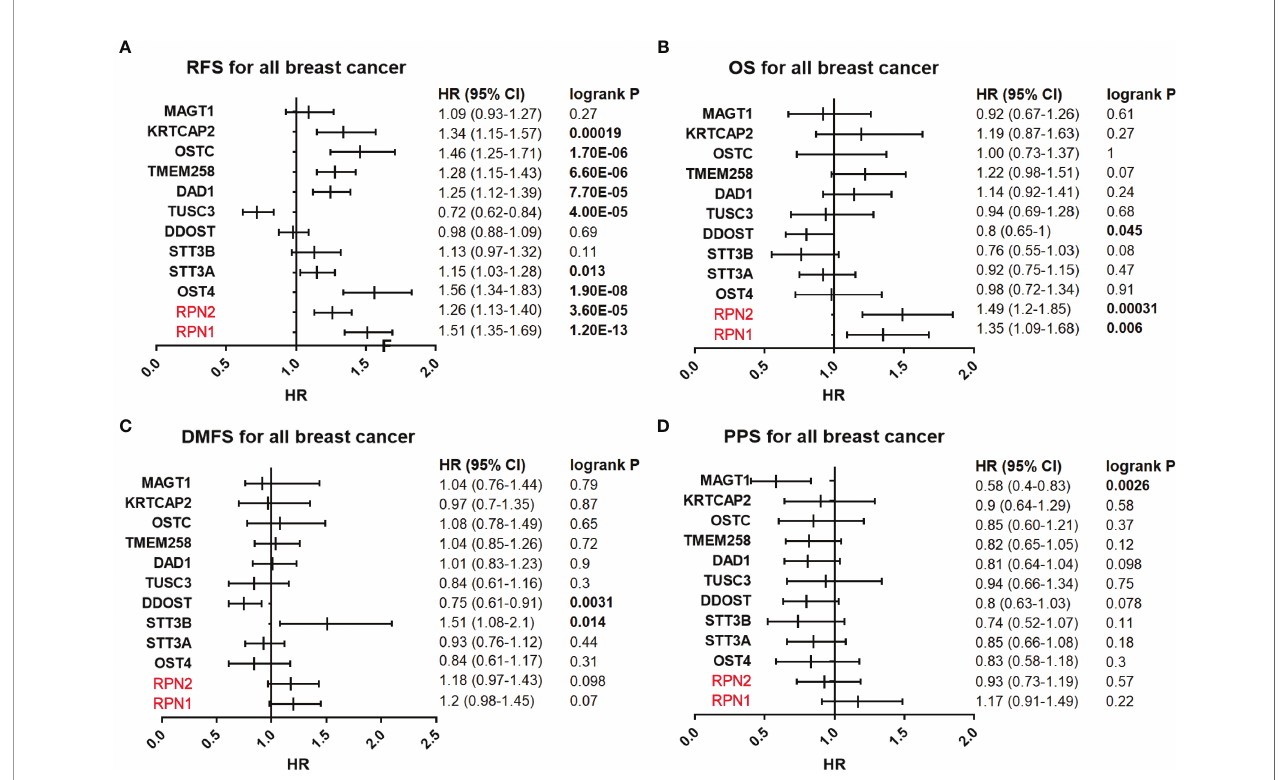
FIGURE 5 | Survival analyses of the OST subunits in breast cancer (RFS, PS, DMFS, PPS in Kaplan – Meier Plotter). (A – D) Prognostic HR of RFS, OS, DMFS, and PPS of individual OST subunits in all breast cancers. The data with statistical signi fi cance (P<0.05) were marked in bold text. RFS, relapse-free survival; OS, overall survival; DMFS, distant metastasis-free survival; PPS, post-progression survival; HR, hazard ratio; CI, con fi dence interval.